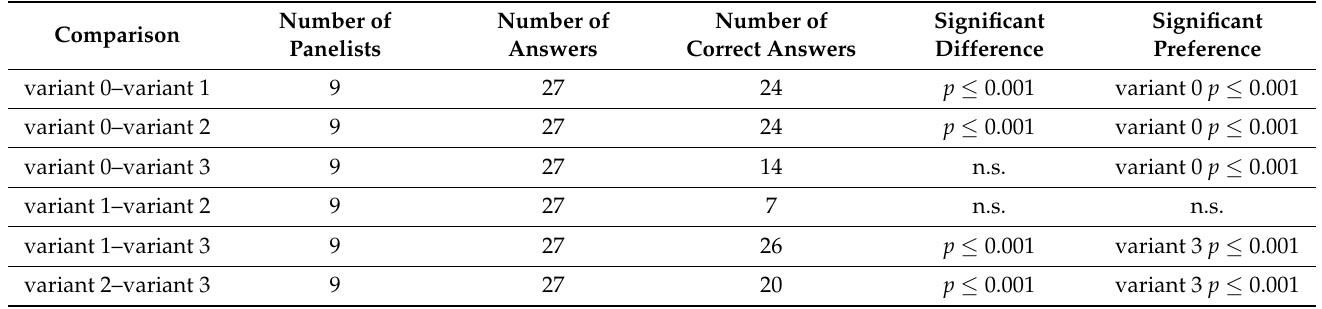
Table 4. Evaluation of the triangle tests in the big-scale experiment according to the significance table at the significance level p > 0.05 (not significant, n.s.), p ≤ 0.05 (significant), p ≤ 0.01 (highly significant), and p ≤ 0.001 (very highly significant) of [37].